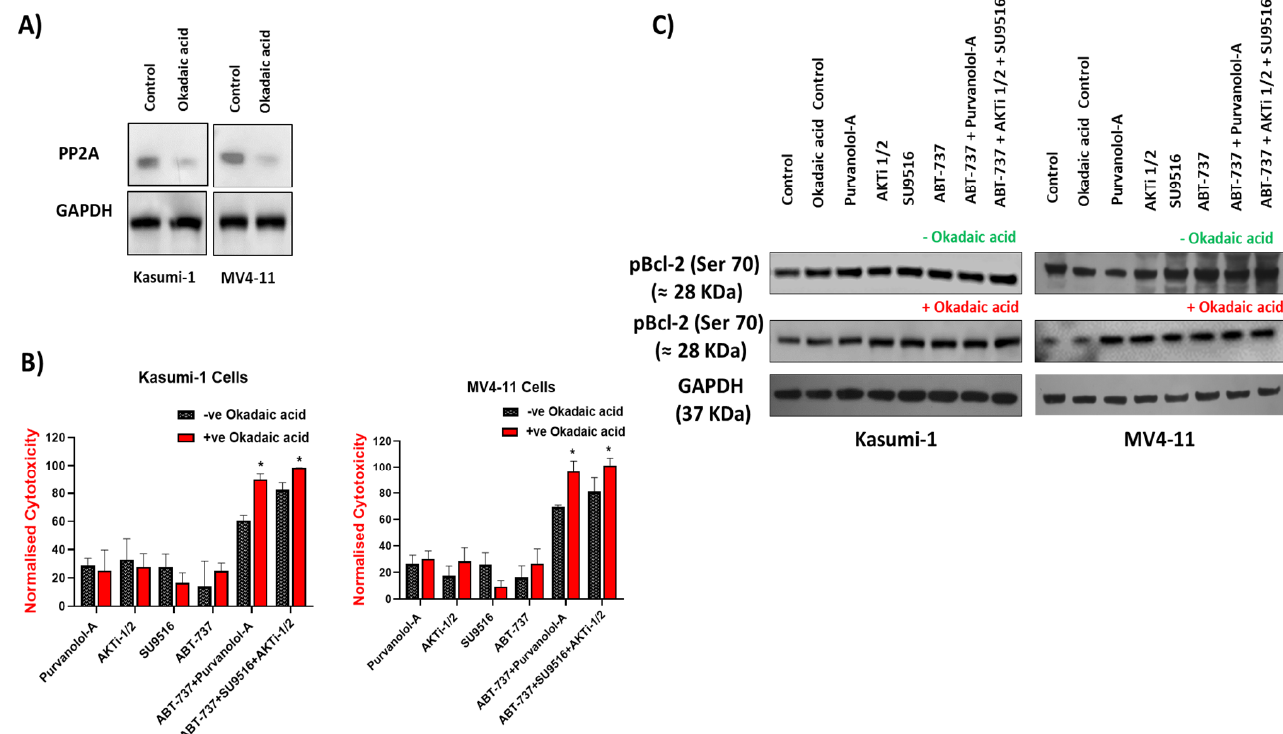
Figure 6. Bcl-2 phosphorylation was not regulated by PP2A phosphatase activities in AML cells. Kasumi-1 and MV4-11 cell lines were treated with 1 nM okadaic acid (OA) for 72 h, and total protein extracts were analysed for PP2A ( A ) or pBCL-2, BCL-2, and GAPDH expression ( C ). ( B ) Kasumi-1 and MV4-11 cell lines were co-treated with 1 nM OA and single/combination treatments for 72 h. Cells were treated with 0.1% DMSO as a vehicle control. Cell toxicity was assessed at 72 h using the CellTox Green Cytotoxicity Assay which was added to the cell suspension, and cells were incubated for 20 min at room temperature before reading. Relative fluorescence unit (RFU) (Ex: 485 nm, Em: 520 nm) was measured using a Synergy HTX Multi-Mode Microplate reader. Data were normalised to vehicle controls and are representative of N = 3 ± SEM. * = p < 0.05.